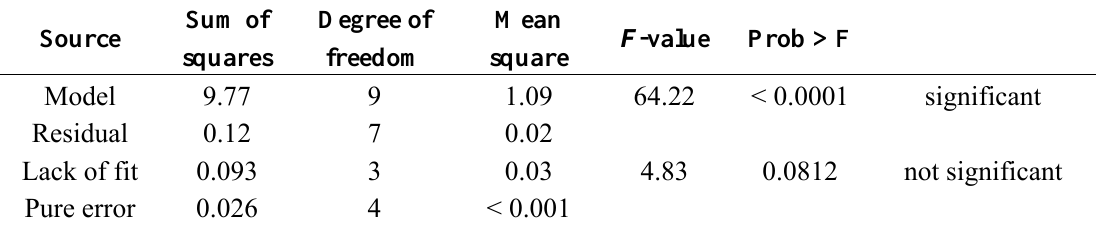
Table 2. Analysis of variance for the fitted quadratic polynomial model of extraction of syringin. Sum of Source squares